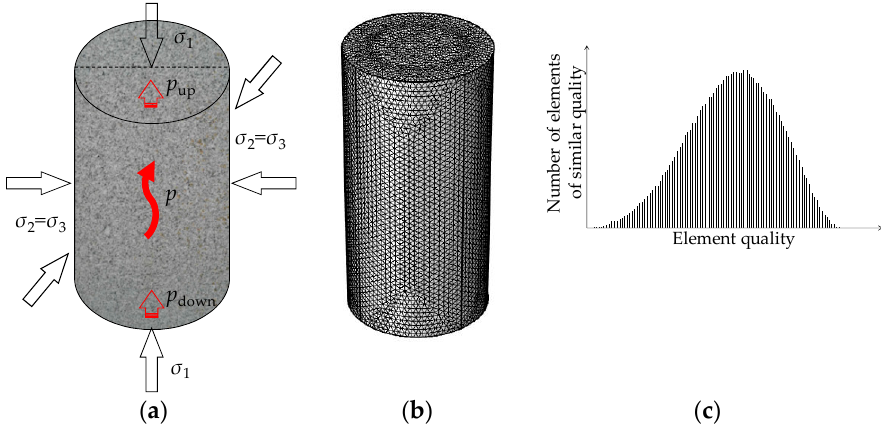
Figure 5. Three-dimensional (3D) numerical model: ( a ) The setup for modeling; ( b ) The discrete mesh with 422,051 elements; ( c ) Element quality histogram.